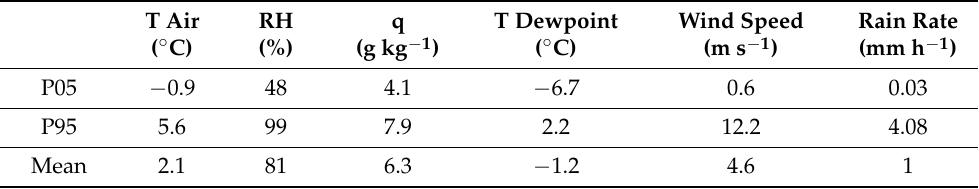
summary of 15-min measurements at PRAA station for the July 2019–July 2020 season. Table 1. Summary of 15 min data series at PRAA station for July 2019–July 2020 monitoring period. P5 and P95 correspond to percentile 5 and 95, respectively. Rain rate corresponds to measured val- ues at Parsivel disdrometer. P05 and P95 are the percentiles 5 and 95, respectively.